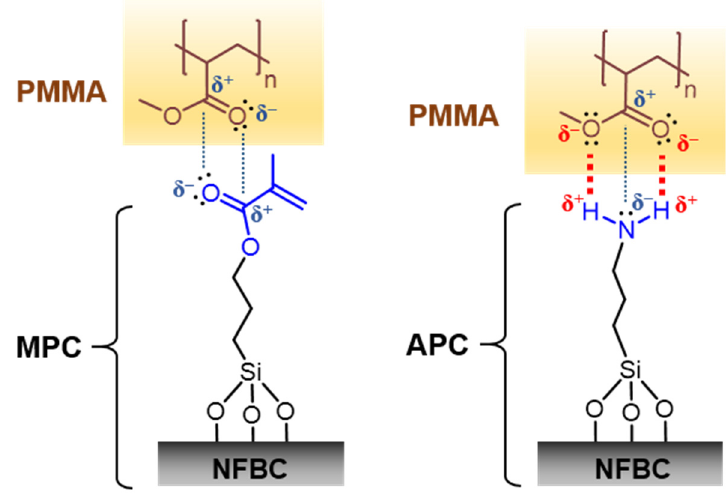
Figure 12. Differences in the molecular structures of NFBCs modified with MPTMS (left, MPC) and APTMS (APC, right), and intermolecular forces formed with PMMA.